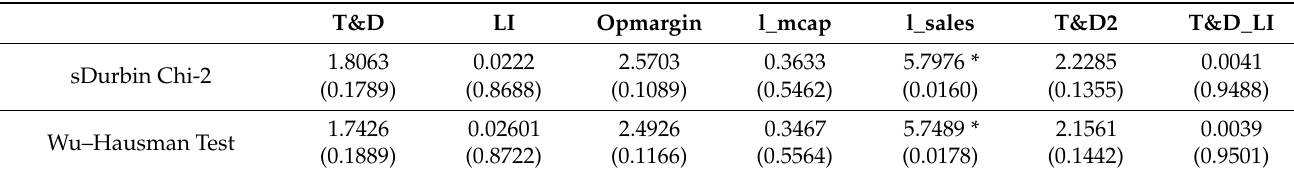
Table 10. Endogeneity